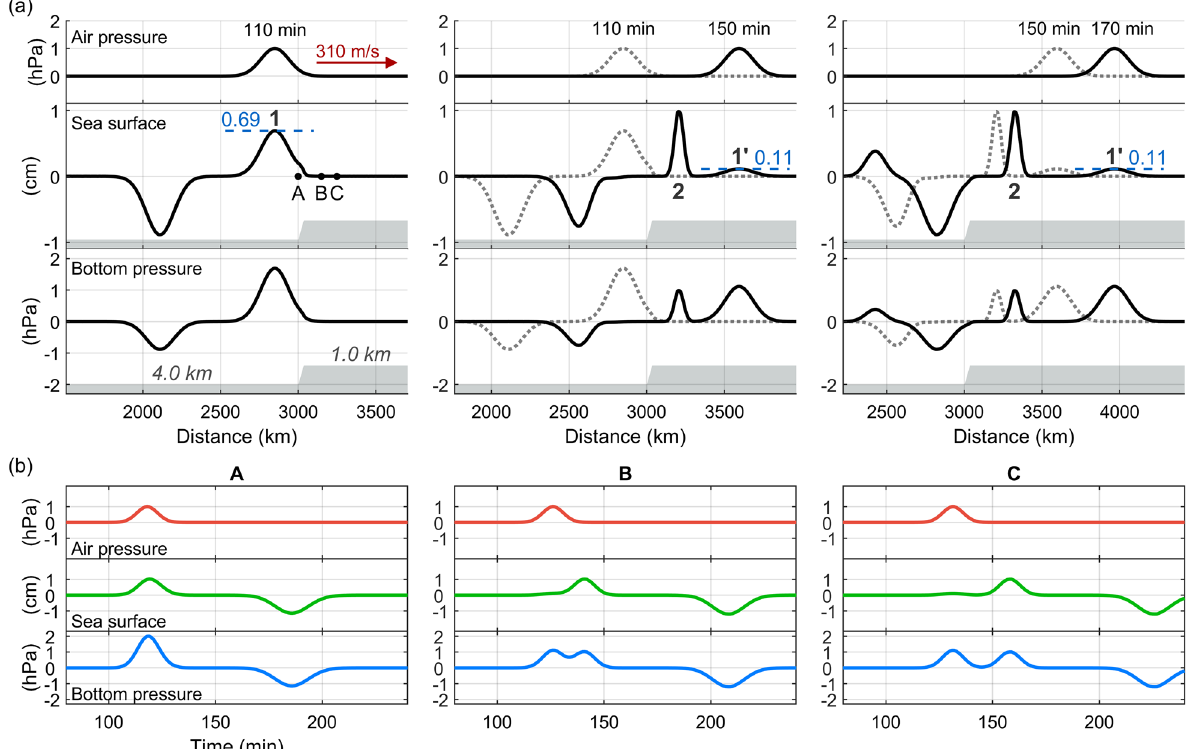
Fig. 2 The synthetic test of an air pressure wave traveling at 310 m/s passing over a 5° updip slope from a depth of 4 km to a depth of 1 km. a The wave profiles of air pressure (upper row), sea surface (middle row), and bottom pressure (lower row) along x- direction extracted at y times on the top of the air pressure wave indicate the origin time of the snapshots of the solid or dotted lines. The waves marked with 1, 1 ′ , and 2 are the incident pressure‑forced wave, transmitted pressure‑forced wave, and the generated ocean gravity wave, respectively. A, B, and C in the left column indicate the locations where we measured the time‑series waveforms shown in b . b The waveforms at locations A (left), B (middle), and C (right). The red, green, and blue lines represent the waveforms of the air pressure wave, sea surface height, and bottom pressure,